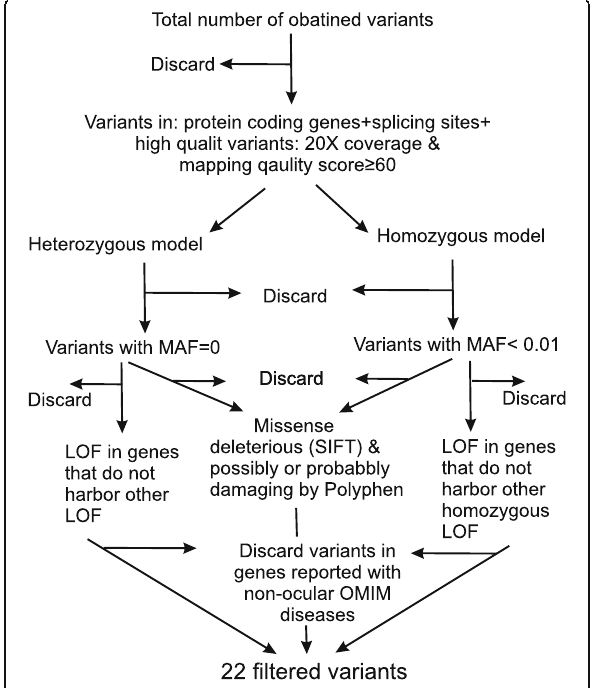
Fig. 1 Variants filtration chart. MAF: minor allele frequency, LOF: loss of